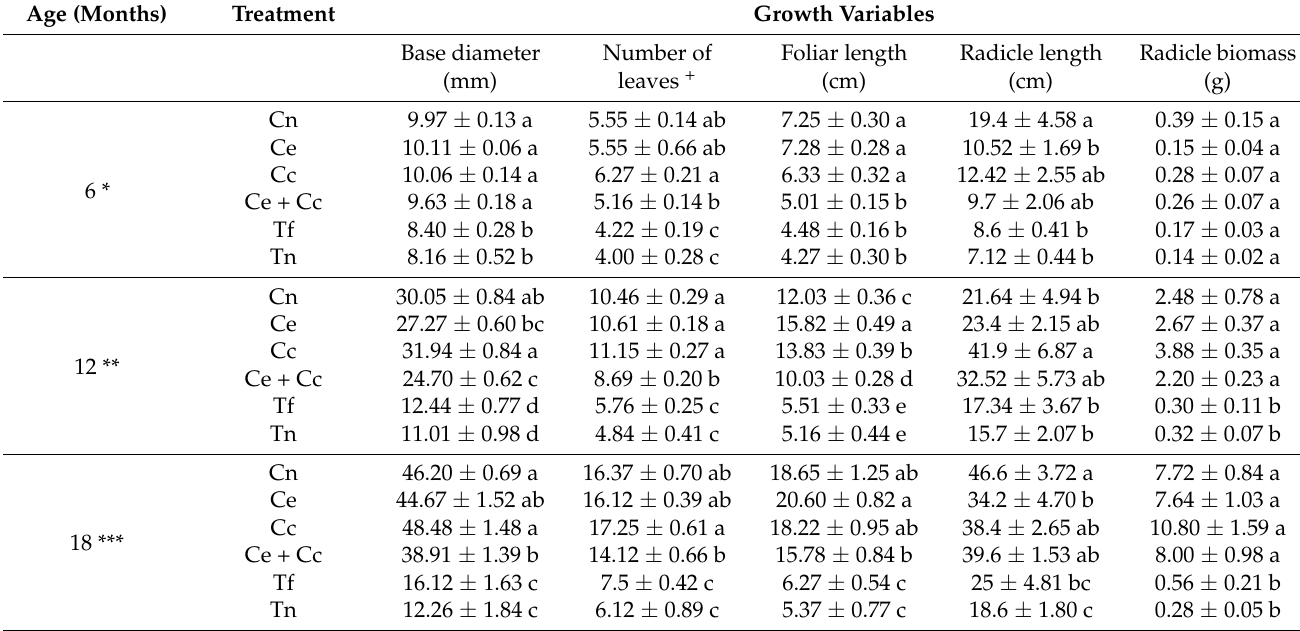
Table 2. Growth indicators of Agave maximiliana inoculated with arbuscular mycorrhizal fungi (AMF) at 6, 12, and 18 months under greenhouse conditions. Treatments: (1) consortium of autochthonous AMF of the A. maximiliana rhizosphere (Cn), (2) Claroideoglomus etunicatum (Ce), (3) Claroideoglomus claroideum (Cc), (4) C. etunicatum + C. claroideum (Ce + Cc), (5) control with fertilization and without mycorrhizal inoculation (Tf), and (6) control without fertilization or mycorrhizal inoculation